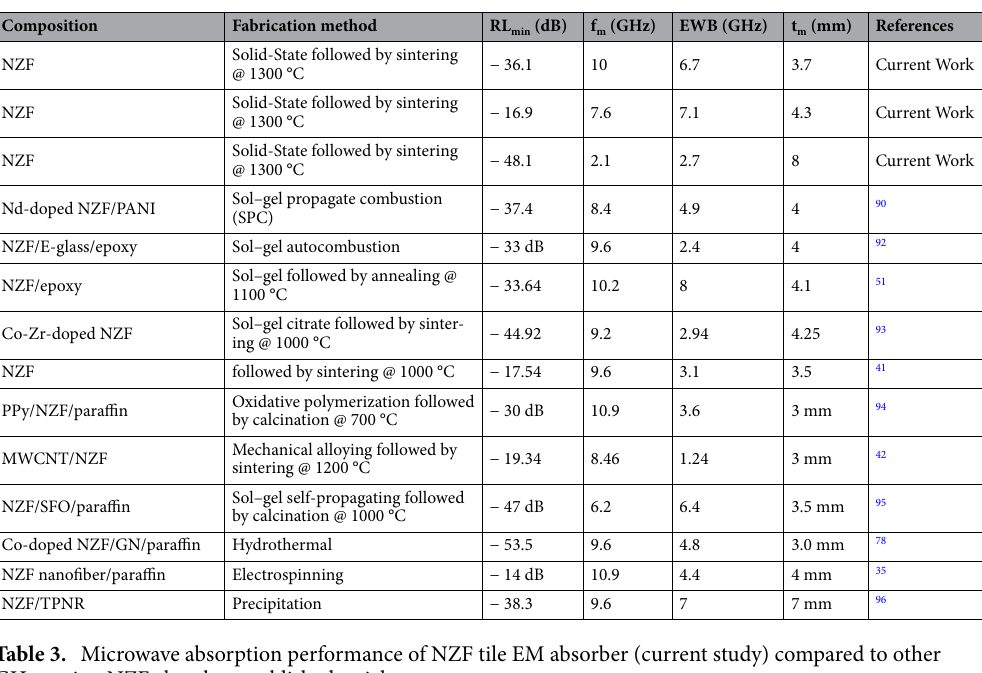
Table 3. Microwave absorption performance of NZF tile EM absorber (current study) compared to other GHz-region NZF absorbers published articles.